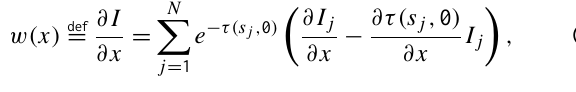
Figure 2. The two- and three-dimensional atmospheric grids used in HR. (a) A grid is shown consisting of altitude and angle along the line of sight direction, however, the plane can be placed in any direction (latitude, solar zenith angle, etc.). (b) The Delaunay grid used for three-dimensional atmospheres. The barycentric interpola- tion on the surface of the Earth is also